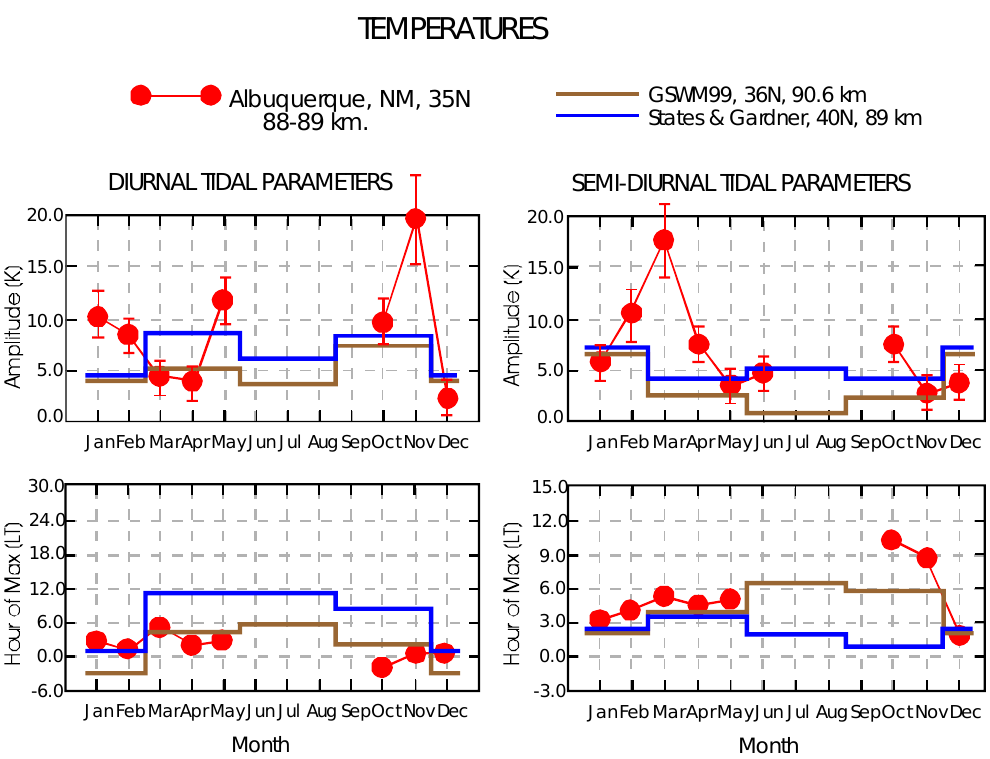
Fig. 8. Meteor temperature tidal parameters plotted as a function of month of the year for 88–89 km altitude for Albuquerque, New Mexico, compared to lidar-derived measurements for Illinois (40 ◦ N) and the GSWM for 36 ◦ N. The meteor data represent vector averages over all available months in the period 1998 to 2000. Error bars are given for the amplitudes. For the phases (times of maximum), the errors are smaller than the symbols